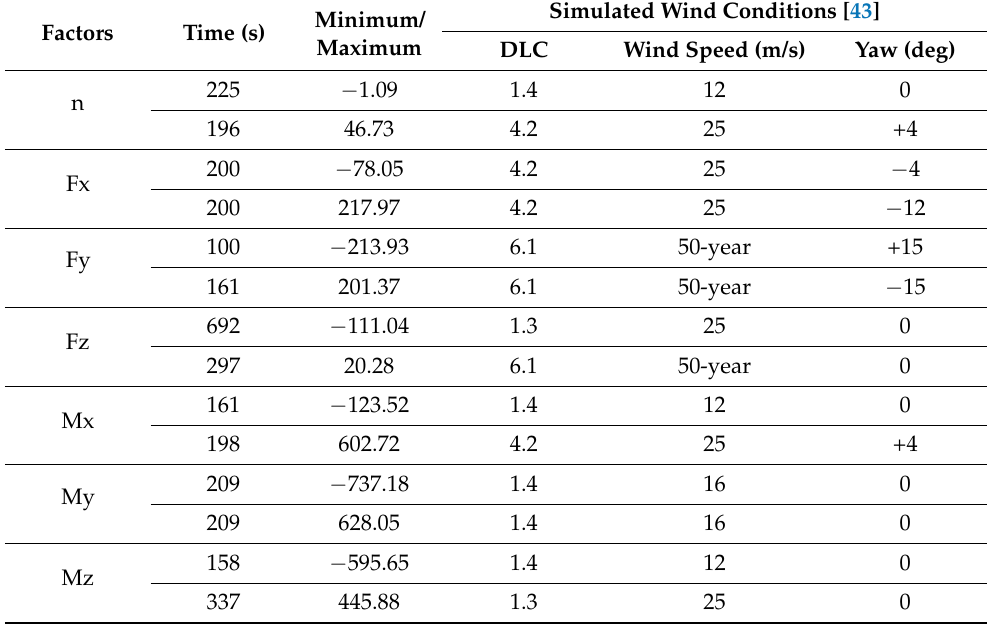
Table 5. Factor Statistics from Aeroelastic Multibody Simulations of Vestas V52 WT.